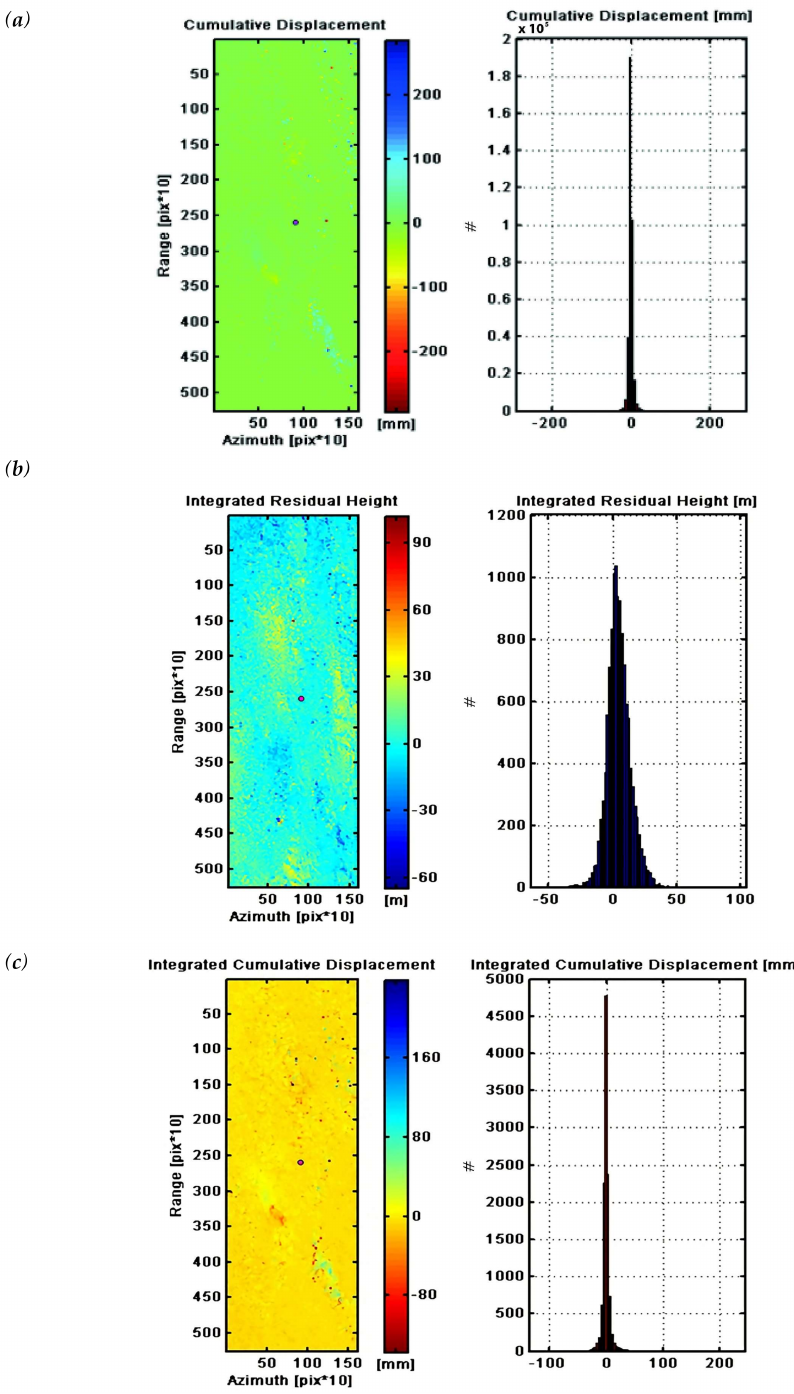
Figure 3. Displacement histograms and maps after Atmospheric Phase Screening (APS) removal. ( a ) Cumulative displacement, ( b ) Integrated residual height, ( c ) Integrated cumulative displacement (Single Red Point: Selected